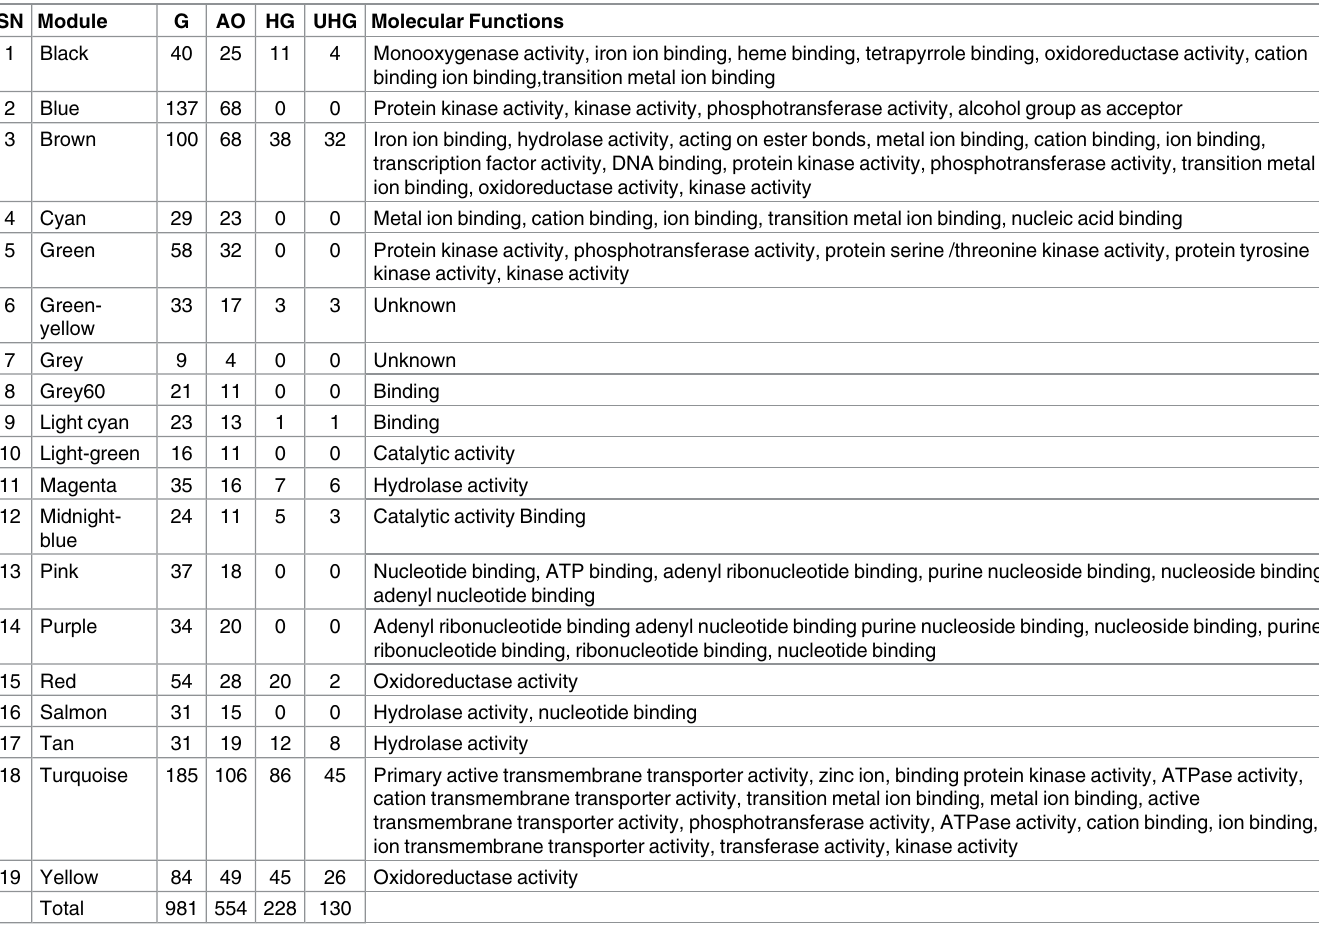
SN: Serial number of module; grey module: genes which do not belong to any module are shown with grey colour; Module: module represented by colours; G: Number of genes belongs to the modules; AO: Number of Arabidopsis orthologs genes belong to each module; HG: Number of hub genes belong to each module; UHG: number of hub genes unique to stress